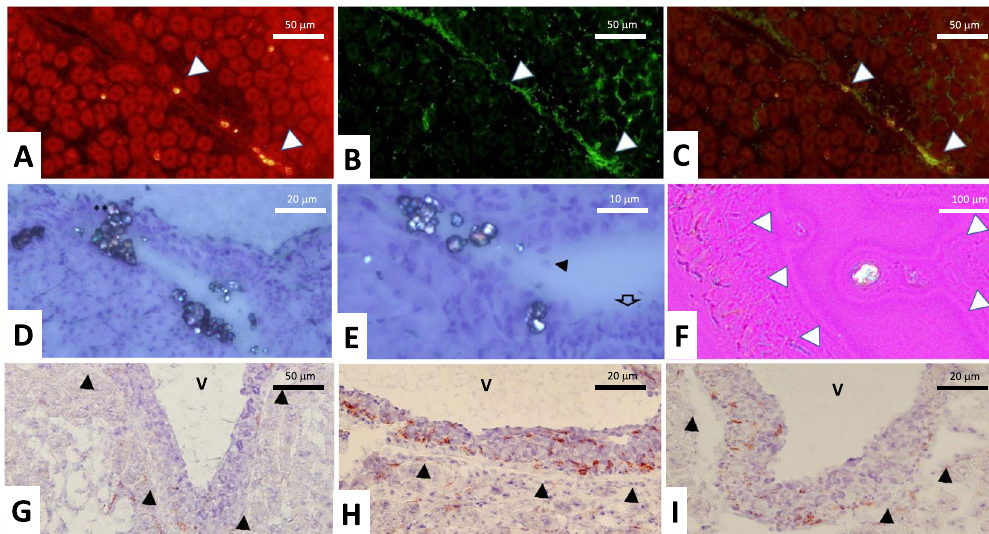
Figure 6. ( A – C ) Localization of KI67/CD44 at day 42. KI67 staining ( A ), CD44 staining ( B ) and KI67/CD44 double staining ( C ). ( D – F ) Polarized and non-polarized photographs of COM crystals, located in specialized fornix areas at day 42 with some detached urothelial cells in the urinary space (black arrow). Urothelium appears as multilayered (empty arrow). Crystals are detected in the urinary space within the multilayered urothelium ( D , E ) and covered by the urothelium barrier ( F ). ( G – I ) At day 42, F4/80 staining shows fewer positive cells in control group ( G ) compared to HLP ( H ), and HLP + FGF7 group ( I ). White arrows indicate urothelial cells surrounding urinary spaces which are collapsed in most frozen tissue